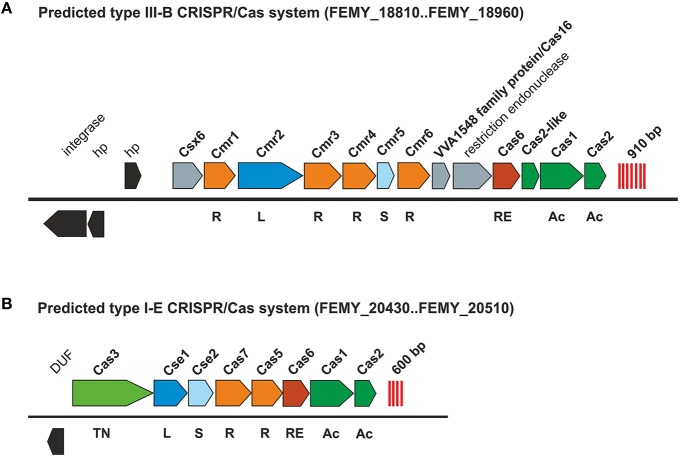
Predicted defense mechanisms against foreign DNA in the genome of “F. myxofaciens” Z-31. The genome of “F. myxofaciens” was predicted to harbor a putative type III-B (A) and a presumed type I-E CRISPR/Cas system (B). Predicted CRISPRs are indicated as red lines. Genes encoding homologous proteins have the same color. Cas 1 and 2 (green) are conserved in both systems and are predicted to be involved in the acquisition (Ac) phase recognizing foreign DNA. The Cascade complex is presumed to consist of multiple subunits including a large (L) and small (S) subunit as well as other subunits (R). A specific nuclease (RE) is predicted to be involved in the maturation process of the pre-crRNA (RNA transcript of the CRISPR array) to crRNA of the active Cascade complex. In type I-E Cas3 functions as DNA endonuclease (TN) degrading the foreign DNA bound to the Cascade complex. Genes encoding other Cas-proteins without a specified function are shown in gray while other protein-coding genes are shown in black.